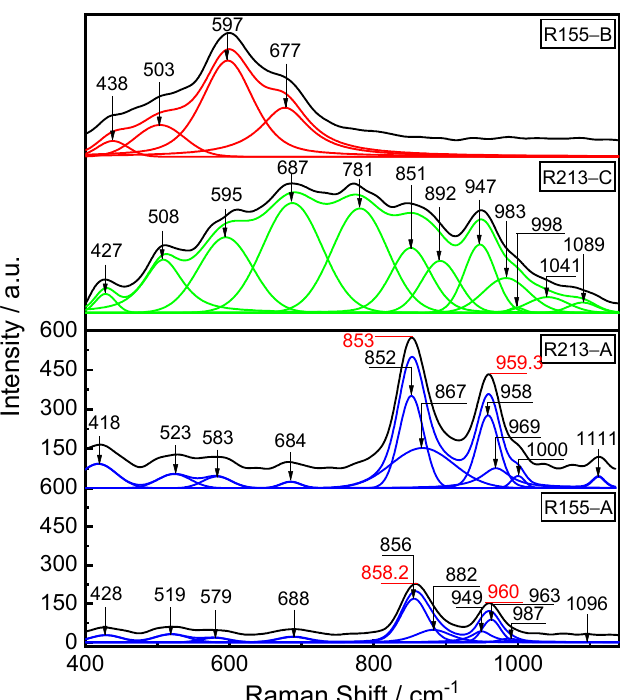
Figure 8. Raman spectra analysis of Fe-rich phase in R155 slag, matrix phase C in R213 slag, and P-rich phases in R155 slag and R213 slag.